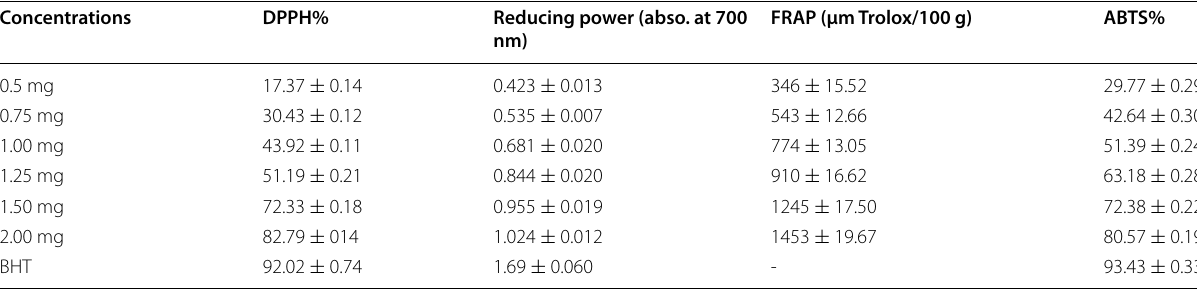
All the values are the average of three independent experiments